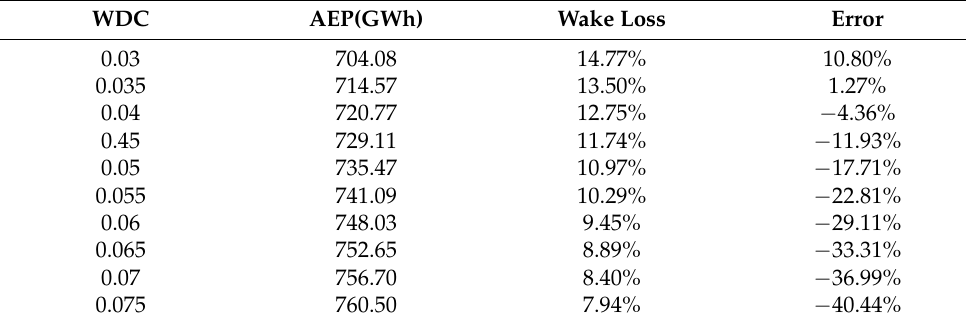
Table 3. AEP and wake loss by different WDC of Xutuozi Wind Farm.